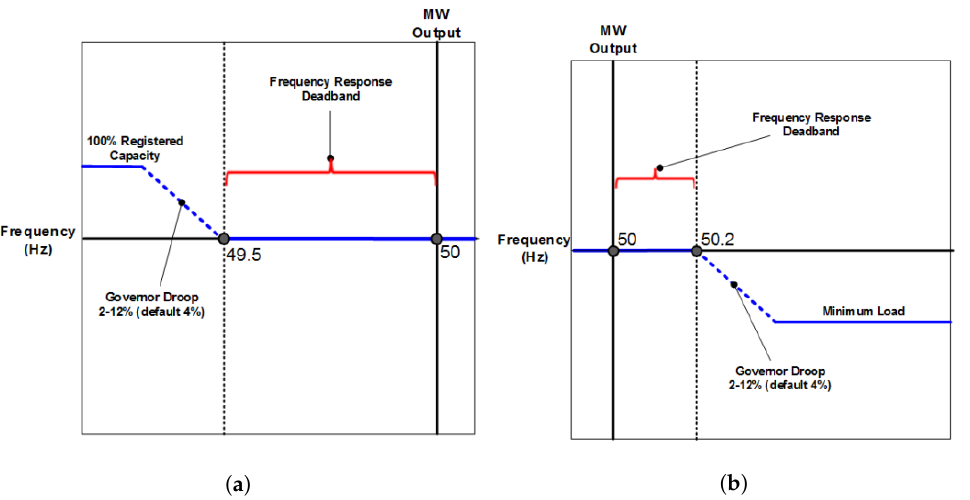
Figure 2. ( a ) Mandatory droop requirements from the Irish grid [14] at dangerously low frequencies. ( b ) Mandatory droop requirements from the Irish grid at dangerously high